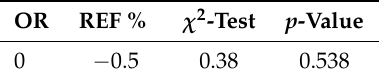
Table 3. Risk Etiologic Fraction (REF) and Chi-square test estimates of effect of ARFE fetal exposure